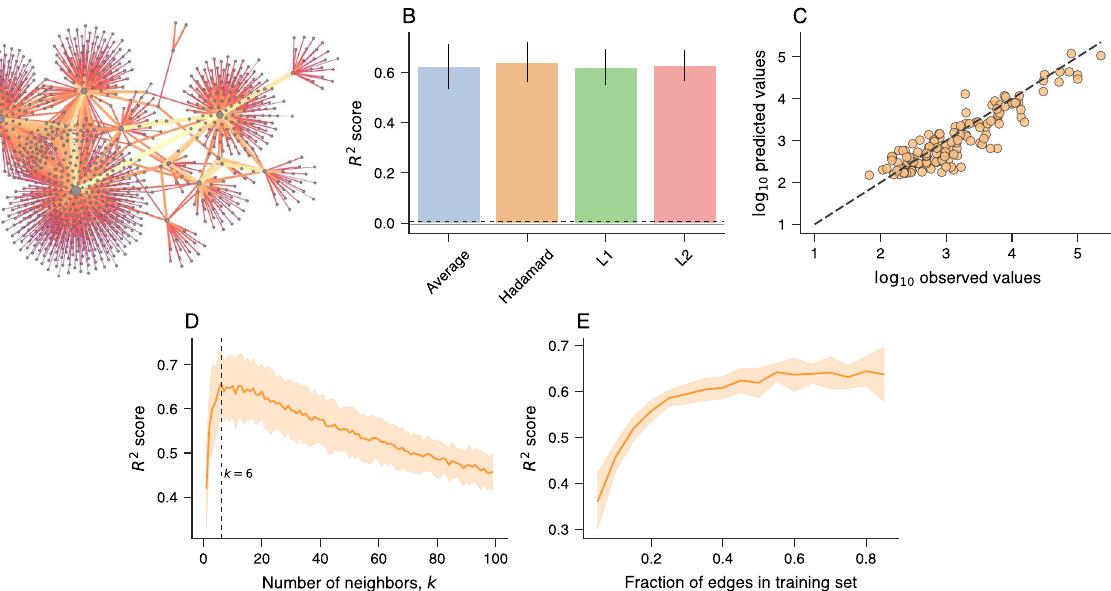
Figure 3. Predicting the total amount of money exchanged among agents of the criminal financial network. ( A ) Visualization of the criminal financial network. Nodes represent agents (people or companies) and edges indicate financial transactions. The thicker the edge and lighter its color, the larger the amount exchanged 2 between a pair of nodes. ( B ) Coefficient of determination ( R score) of the association between the logarithm of the predicted and observed amounts of money exchanged between pairs of nodes in the test sets. These predictions are obtained using k -nearest neighbor regressors ( k NN with k = 6 ) trained with node2vec representations of edges and different binary operators. The bars stand for the average accuracy and error bars represent one standard deviation over ten realizations of the embedding and training processes. The gray continuous line represents the accuracy of a baseline regressor that always predicts the average value of the training set, and the black dashed line represents the accuracy of another dummy regressor that always predicts the median of the training set. ( C ) A typical example of the relationship between the base-10 logarithm of the predicted and observed amounts of money exchanged between pairs of nodes in the test sets obtained with a k NN regressor ( k = 6 ) trained with node2vec representations of edges and the Hadamard operator. The dashed 2 line represents the 1:1 relationship. ( D ) Average R score as a function of the number of neighbors ( k ) in the k NN regressors estimated from the test sets. The vertical dashed line indicates the optimal number of neighbors 2 ( k = 6 ). ( E ) Average R score on the test sets as a function of the fraction nodes in the training sets. In the last 2 two panels, the solid lines indicate the average R score, and the shaded regions stand for one standard deviation band estimated over ten realizations of the embedding and training processes with the Hadamard